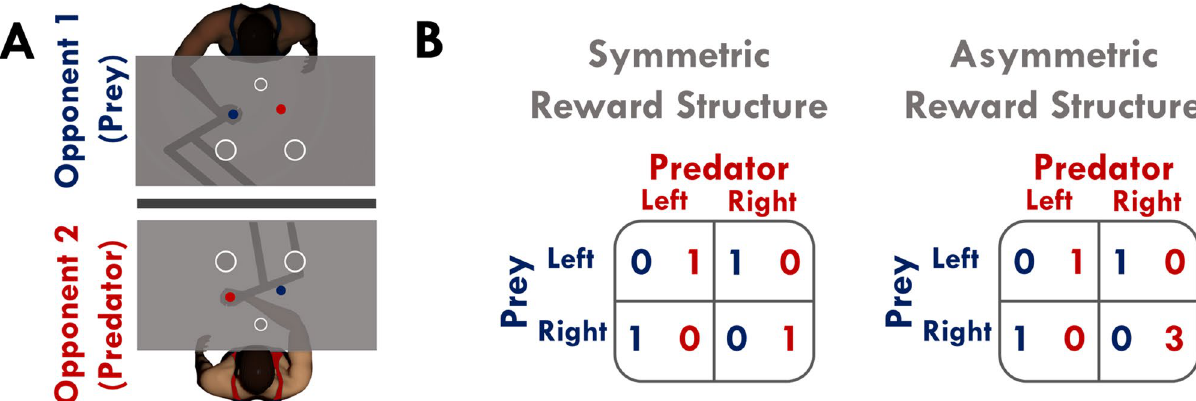
Figure 1. Experiment 1 and 2 design. ( A ) Participants from a human pair each controlled a cursor located at the position of the robot handle. Each participant could see their opponent’s cursor on their respective screens throughout the trial. At the start of each trial, participants placed their cursor in the start position (smaller white ring). Then participants heard a first beep and two targets (larger white rings) would appear. They were instructed to reach forward and move their cursor into one of the two targets before a second beep. Human pairs were randomly assigned to the roles of predator (dark red) and prey (dark blue). The predator won a trial by reaching to the same target as the prey, whereas the prey won a trial by reaching to the opposite target from that of the predator. ( B ) For the symmetric reward structure, the winner of a trial received 1 point and the loser received 0 points. The asymmetric reward structure was similar to the symmetric reward condition, with the exception that the predator received 3 points if both the predator and prey selected the right target. For Experiment 1 and 2, we controlled available time before the second beep (e.g., short = 500 ms, medium = 850 ms, or long = 1500 ms) to manipulate the amount of sensory evidence that a participant